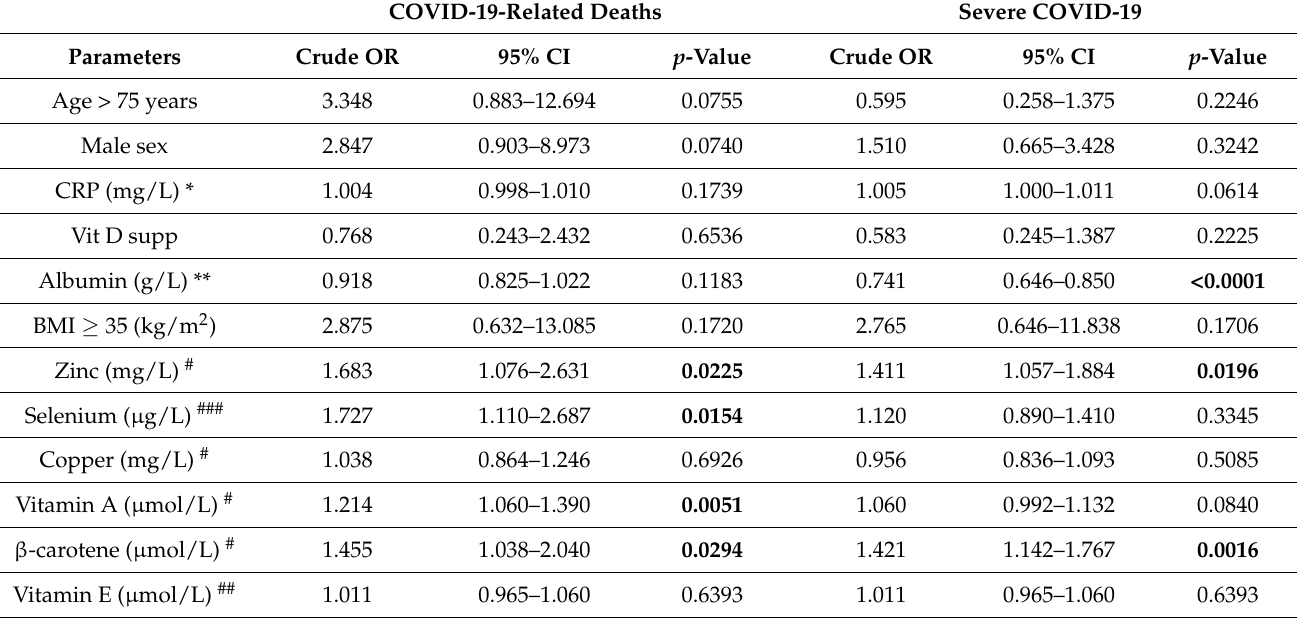
Table 3. Univariate logistic regression analysis of the association between plasma micronutrients levels and COVID-19-related deaths and severe forms in the 94 patients.